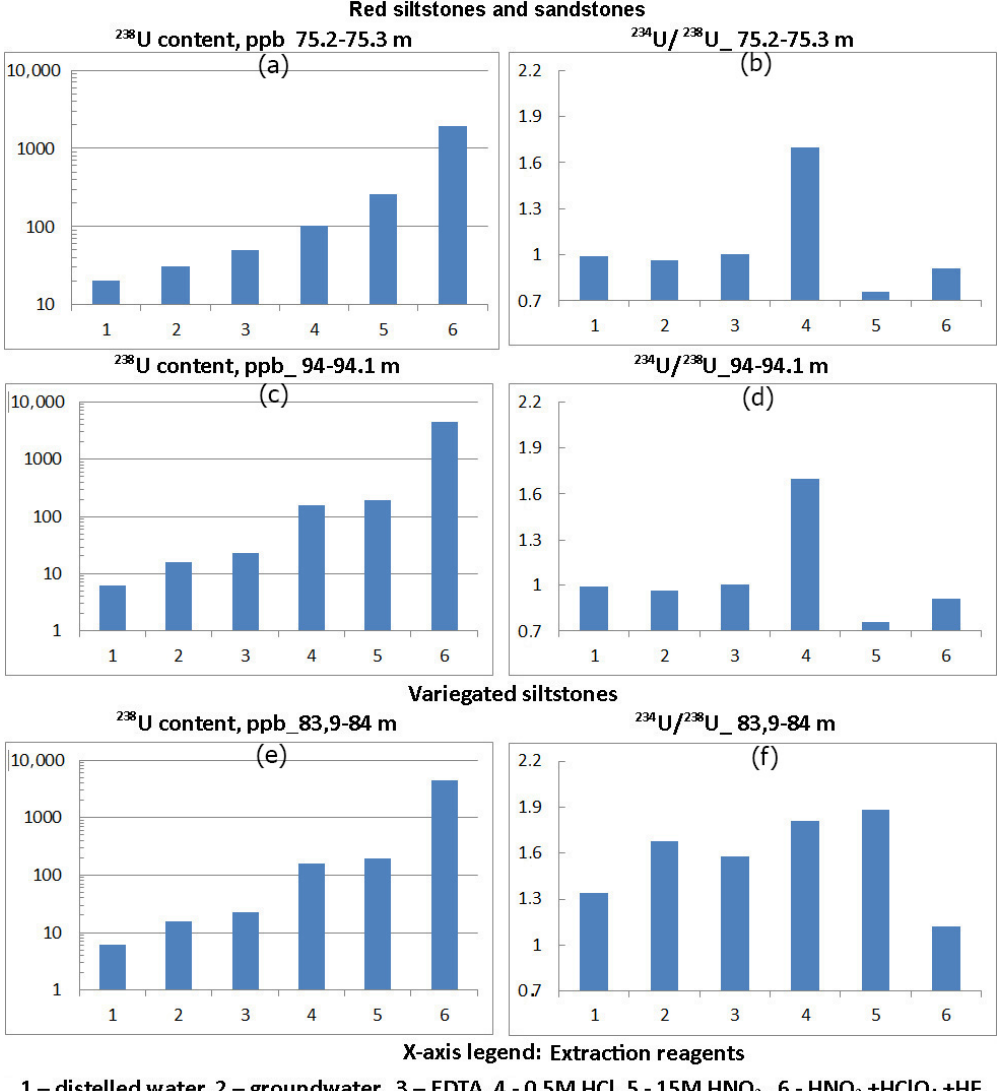
Figure 2. Distribution of 238 U content and 234 U: 238 U activity ratio in phases 1–6, leached from crushed red and variegated siltstone of Vendian (Ediacaran) Padun Formations.